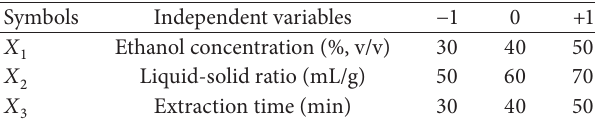
Table 1: Code and level of factors chosen for the trials.